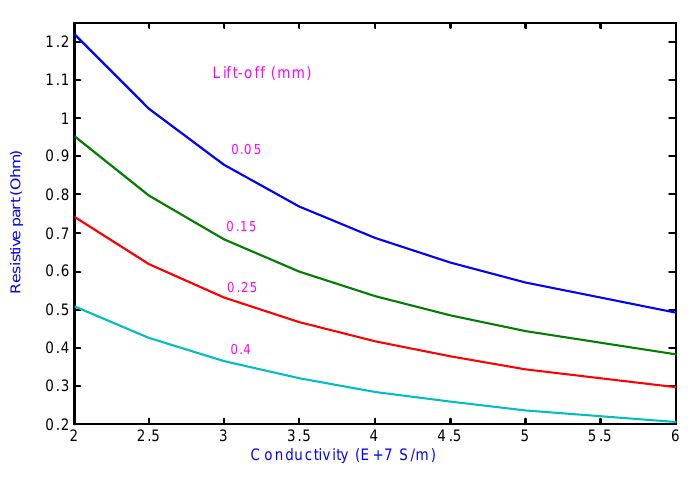
Figure 18. Variation of the real part of transfer impedance with conductivity at 500 kHz for Mesh type sensor.